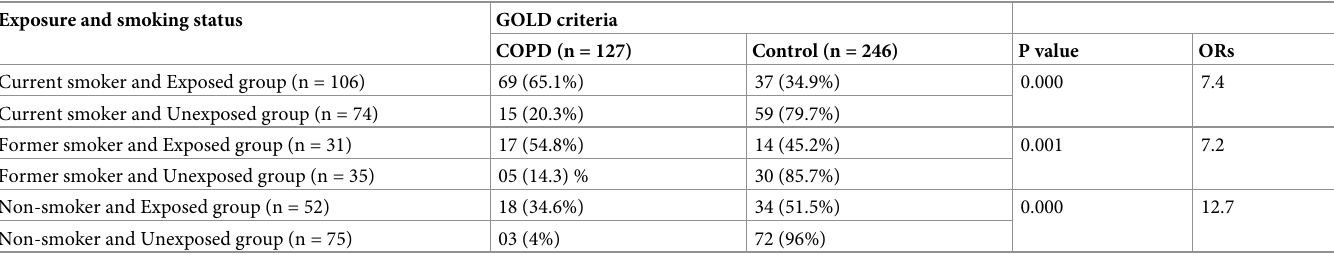
Table 6. Combined influence of smoking habit and self-reported occupational exposures on COPD.